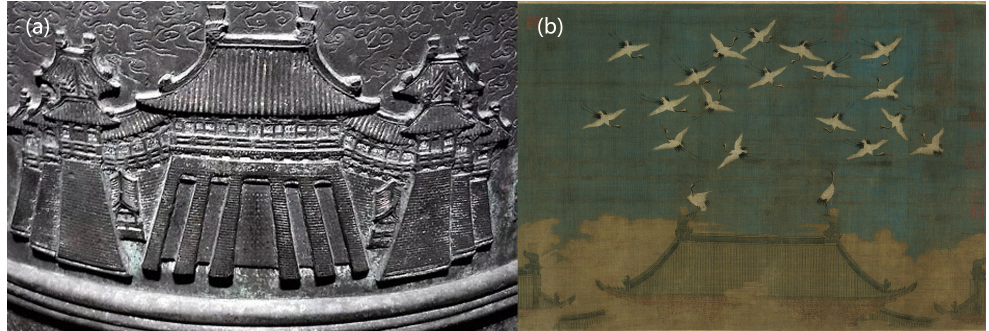
Figure 20. ( a ) The Xuande Gate painted on the bronze bell of Dashengfu in the Northern Song Dynasty, taken by the author at Liaoning Museum; ( b ) Auspicious